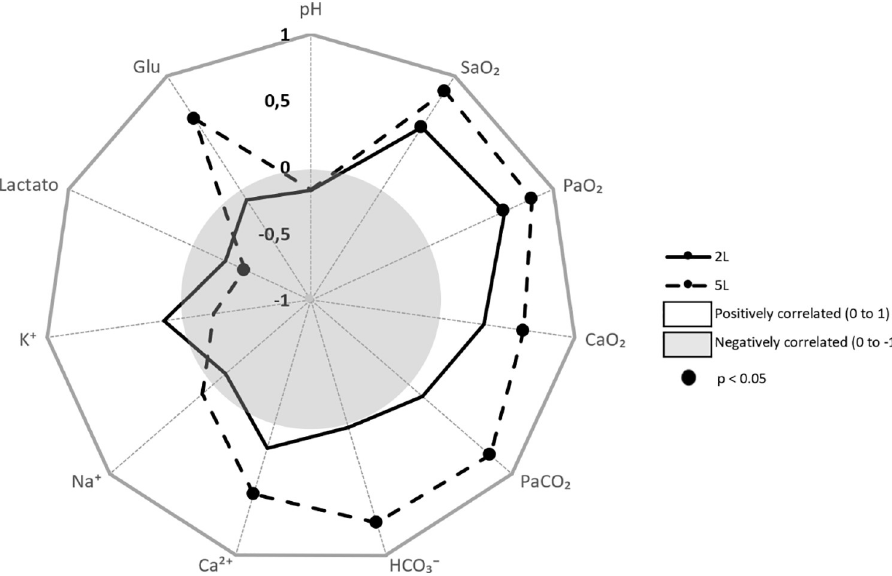
Fig 1. Pearson’s correlation coefficient (r) and significance (p) of blood variables with different O 2 flows during immobilisation of free-ranging capybaras ( Hydrochoerus hydrochaeris ). pH, potential hydrogen; SaO 2, haemoglobin oxygen saturation; PaO 2, partial pressure of arterial of oxygen; PaCO 2, partial pressure of arterial of carbon dioxide; HCO 3- , bicarbonate; Ca 2+ , plasma ionised calcium; Na + , plasma sodium; K + , plasma potassium; Glu, glucose; 2L, animals which received 2L/min oxygen supplementation after 30 min until 60 min; 5L, animals which received 5L/min oxygen supplementation after 30 min until 60 min. Vertical axis represents r values. In the bright area, the closer to the edge, the greater the positive correlation. In the dark area, the closer to the centre, the greater the negative correlation. Markers represent a significant correlation (p < 0.05).